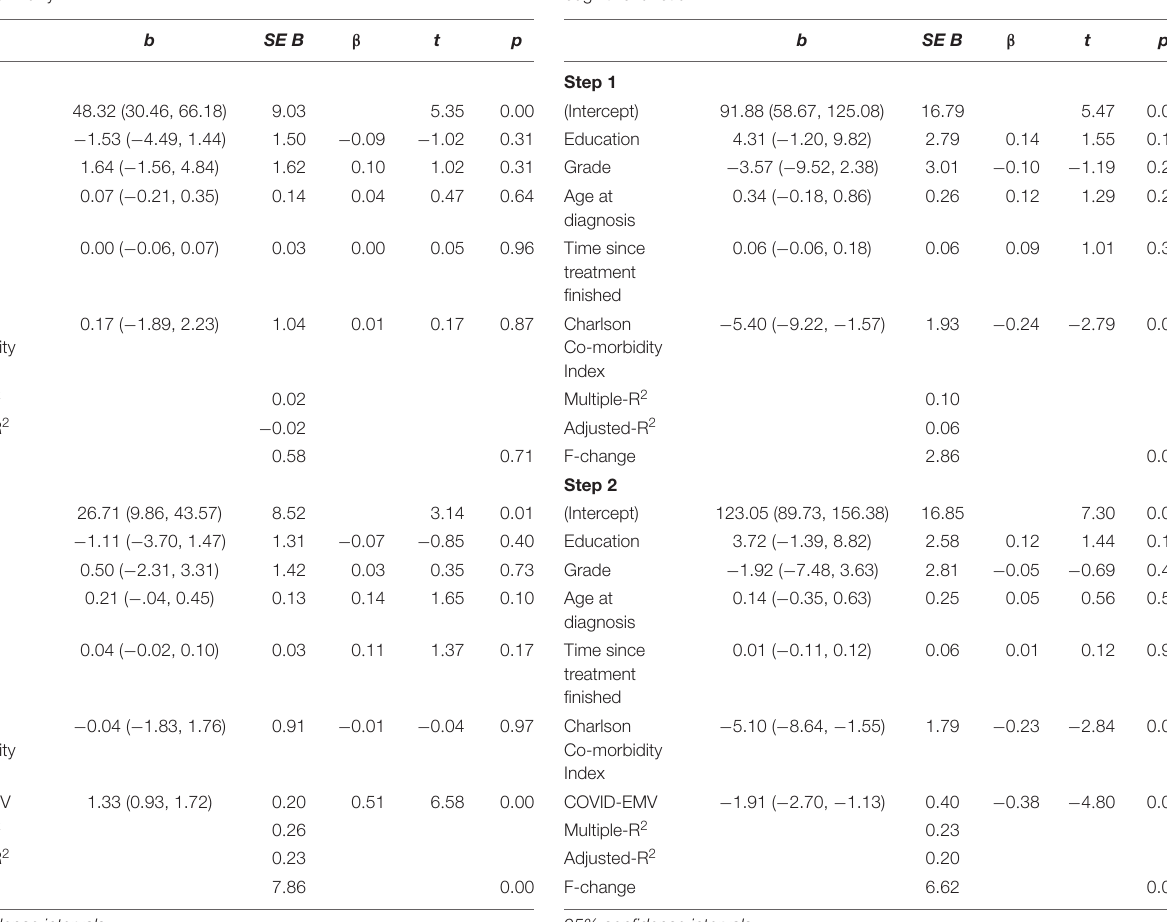
TABLE 4 | Hierarchical regression analyses for the predictors of pathological worry.